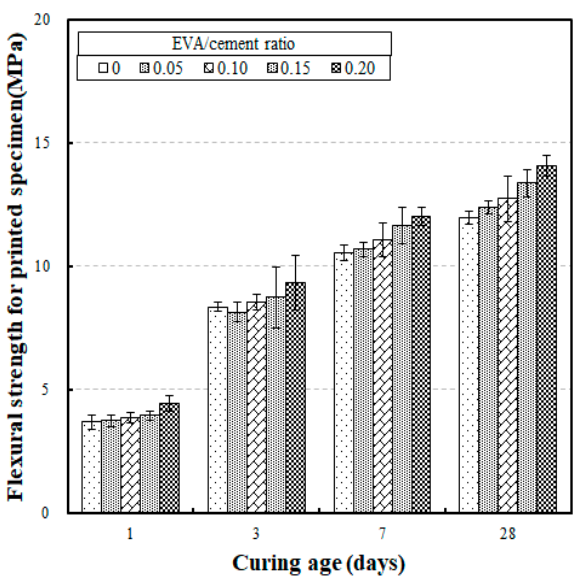
ff erent EVA / cement